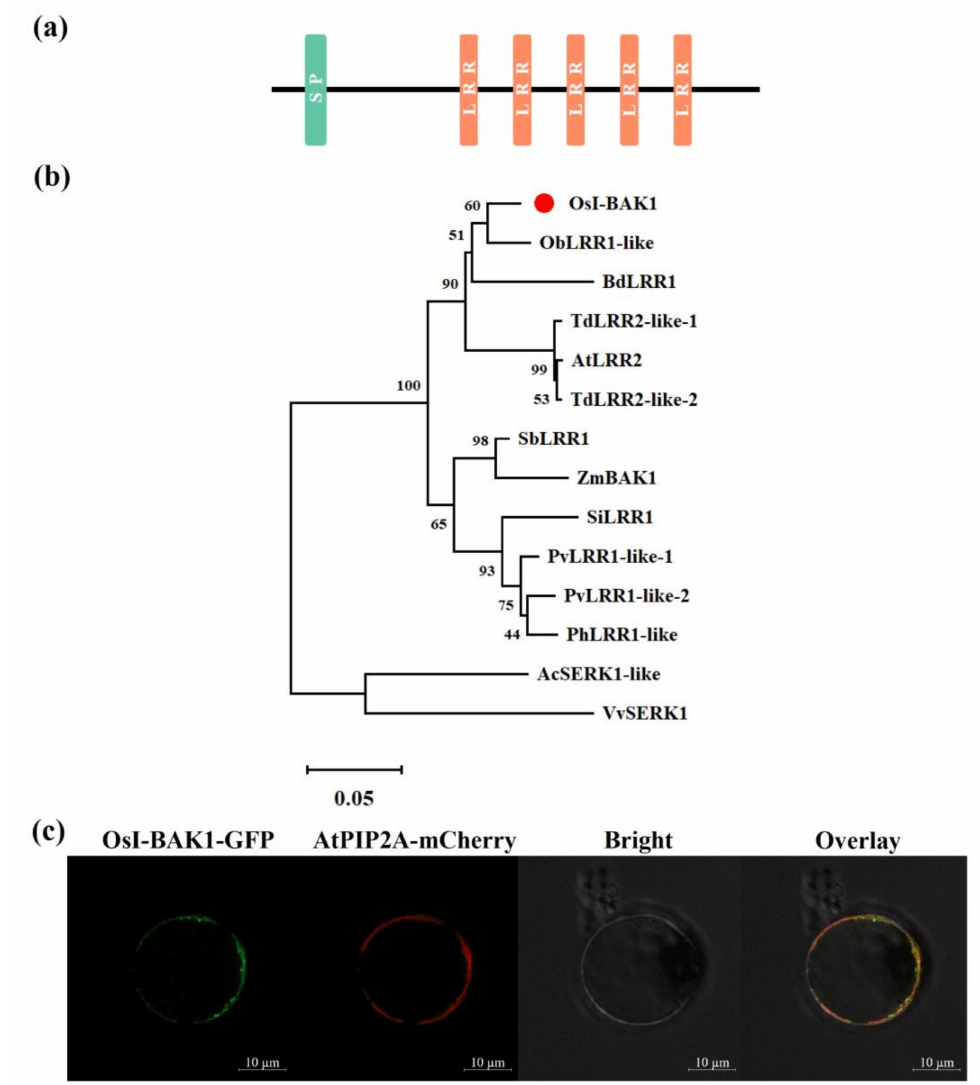
Figure 1. Structure, phylogenetic relationship and subcellular localization of OsI-BAK1. ( a ) Schematic structure of OsI-BAK1. SP, signal peptide; LRR, leucin-rich repeat. ( b ) Sequence alignment of OsI-BAK1 and its homologs. Species abbreviations are included before the protein names: Ac, Ananas comosus ; At, Aegilops tauschii subsp. strangulate ; Bd, Brachypodium distachyon ; Ob, Oryza brachyantha ; Os, Oryza sative ; Ph, Panicum hallii ; Pv, Panicum virgatum ; Sb, Sorghum bi- color ; Si, Setaria italica ; Td, Triticum dicoccoides ; Vv, Vitis vinifera and Zm, Zea mays . Plant species and accession numbers from the NCBI database are as follows: AcSERK1-like, XP_020105022.1; AtLRR2, XP_020193068.1; BdLRR1, XP_003562364.1; ObLRR1-like, XP_006650233.1; OsI-BAK1, XP_015631230.1; PhLRR1-like, XP_025793013.1; PvLRR1-like-1, XP_039825633.1; PvLRR1-like-2, XP_039785598.1; SbLRR1, XP_002467662.1; SiLRR1, XP_004983941.1; TdLRR2-like-1, XP_037465236.1; TdLRR2-like-2, XP_037458478.1; VvSERK1, XP_002263235.1 and ZmBAK1, NP_001148919.1. The red dot indicates OsI-BAK1. The scale bar represents 0.05 amino acid substitution per site in the primary structure. ( c ) Subcellular localization of OsI-BAK1. Polyethylene glycol-mediated transient expression in rice protoplasts of OsI-BAK1-GFP and AtPIP2A-mCherry. OsI-BAK1-GFP, green fluo- rescent protein (GFP) fluorescence from OsI-BAK1-GFP; AtPIP2A-mCherry, mCherry fluorescence from AtPIP2A-mCherry; Bright, bright field and Overlay, co-localization of the OsI-BAK1-GFP and AtPIP2A-mCherry proteins. Bars, 10 µ